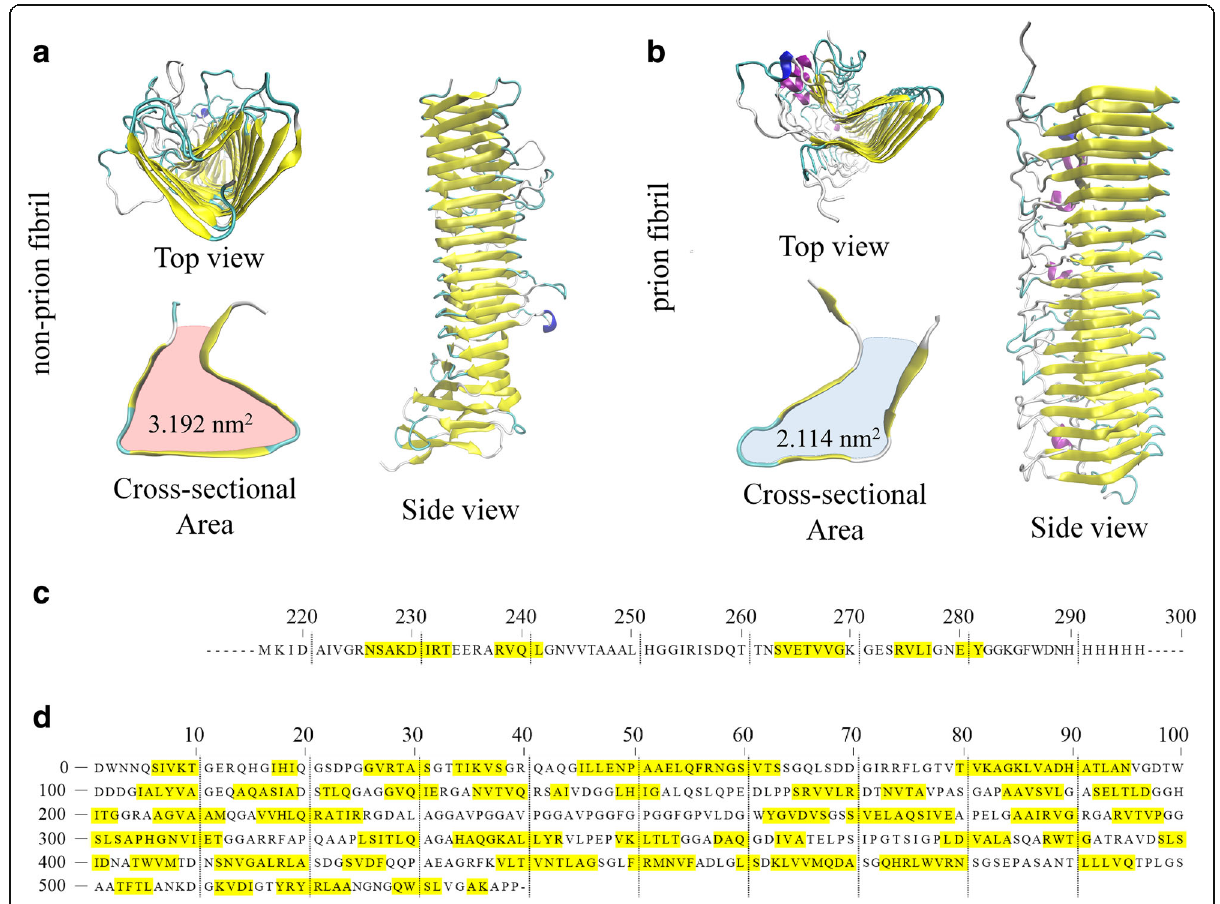
Fig. 1 a Molecular structure of non-prion p69 pertactin fibril. b Atomistic structure of HET-s prion fibril. c Sequence of the segment of HET-s prion fibril. Here, HET-s prion fibril considered in this work is made of nine repeated segments. d Sequence of p69 pertactin fibril. It should be noted that the consecutive sequences highlighted in yellow form a β